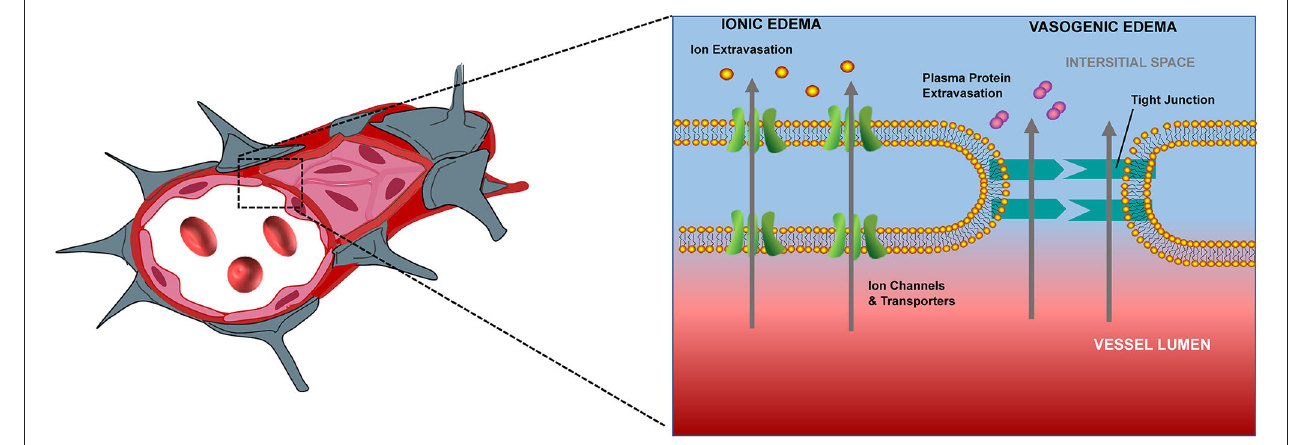
FIGURE 1 | Schema of edema formation after cardiac